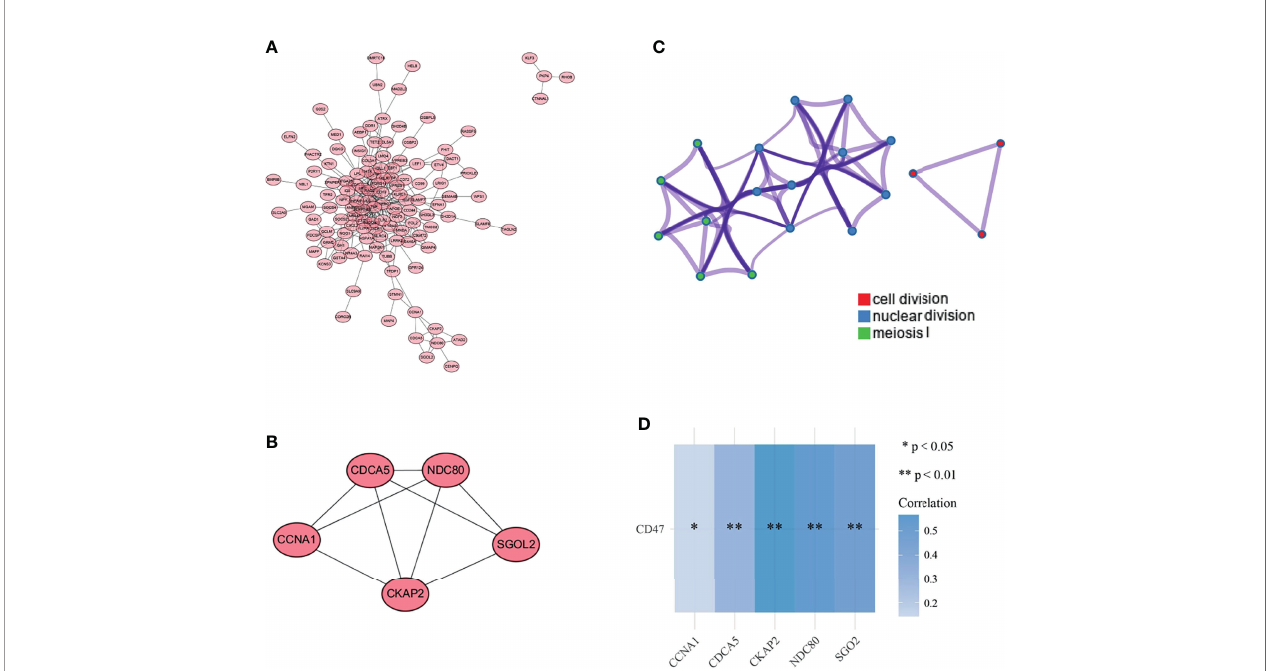
FIGURE 3 | Selection of key gene modules. (A) PPI network of overlapping genes; (B) gene modules with the highest tightness were analyzed by MCODE plug-in (C) ; functional clustering network map of overlapping genes; (D) correlation analysis of CD47 with 5 key genes in the target database (sgol2 is also called sgO2). *P < 0.05, **P < 0.01.